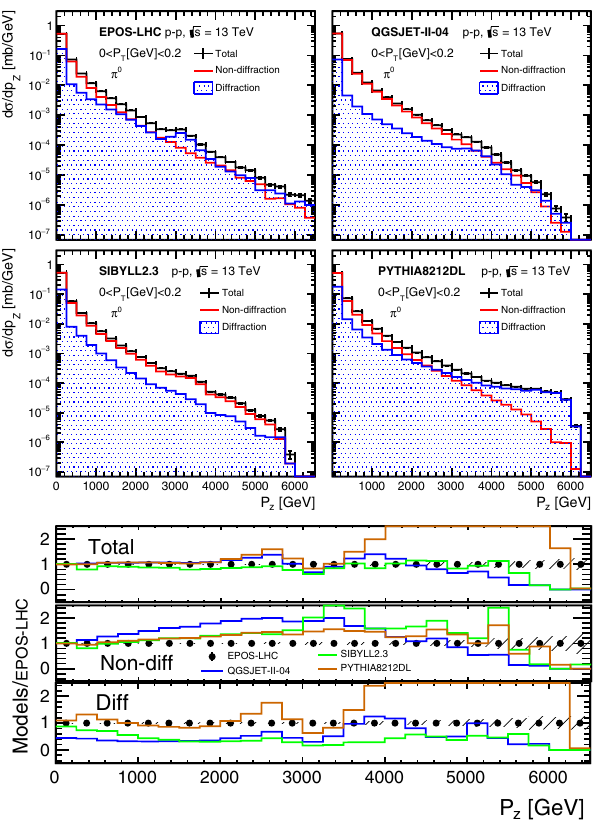
accordingtoMCtrueflags.The bottomthreeplots showtheratiosofthe spectrum of EPOS-LHC ( black markers ), QGSJET-II-04 ( blue lines ), SYBILL 2.3 ( green lines ), and PYTHIA8212DL ( orange lines ) to the spectrum of EPOS-LHC. The top , middle , and bottom plots correspond to total, nondiffraction, and diffraction, respectively